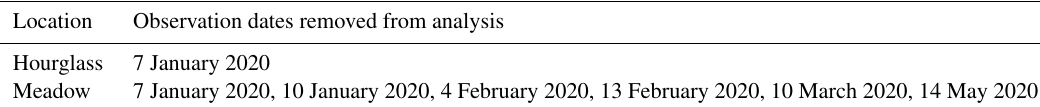
Table A2. Models removed due to poor quality.